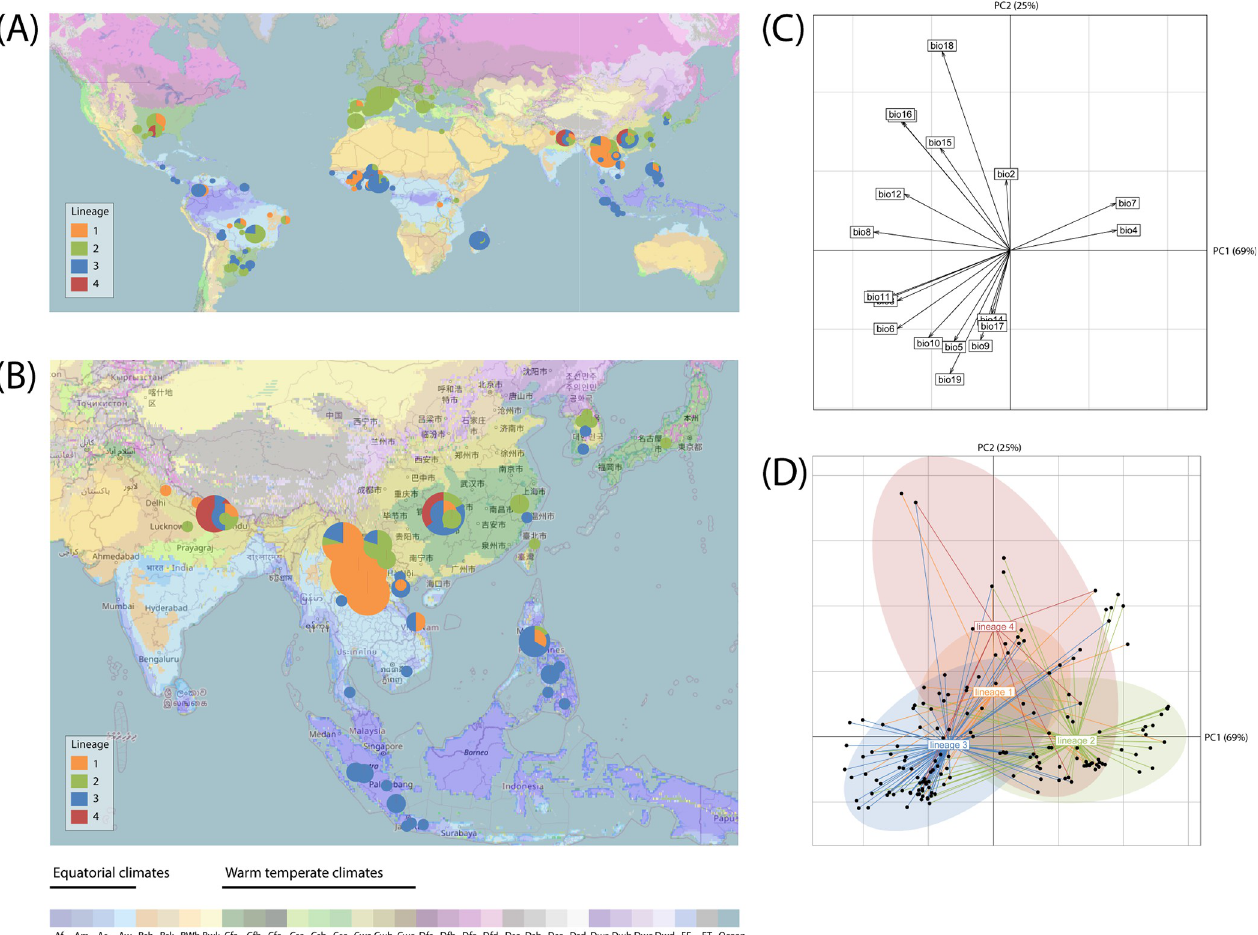
Fig 7. Geographic distribution of four lineages of P . oryzae and corresponding climatic data. (A, B) Pie charts representing the distribution of the four lineages in the world (A) and in South, East and Southeast Asia (B), keeping only isolates for which the sampling position was precisely known (i.e., for which the region, city or GPS position was documented). Background map is from OpenStreetMap (CC-BY-SA) and represents the updated Ko¨ppen-Geiger climate classification of main climates at world scale as described in (62). (C, D) Outlying Mean Index analysis, testing the separation of ecological niches among lineages, with (C) canonical weights of the 19 environmental variables included in the analysis, and (D) site coordinates (dots) and realized niches of lineages represented as ellipses. Variable bio13 co-localizes with bio16, and variables bio1 and bio3 co-localize with bio11. The 11 temperate variables included in the analysis are listed in the Materials and Methods section. PC1 and PC2 in panels C and D represent the first and second principal components, respectively, with percentage of variation between